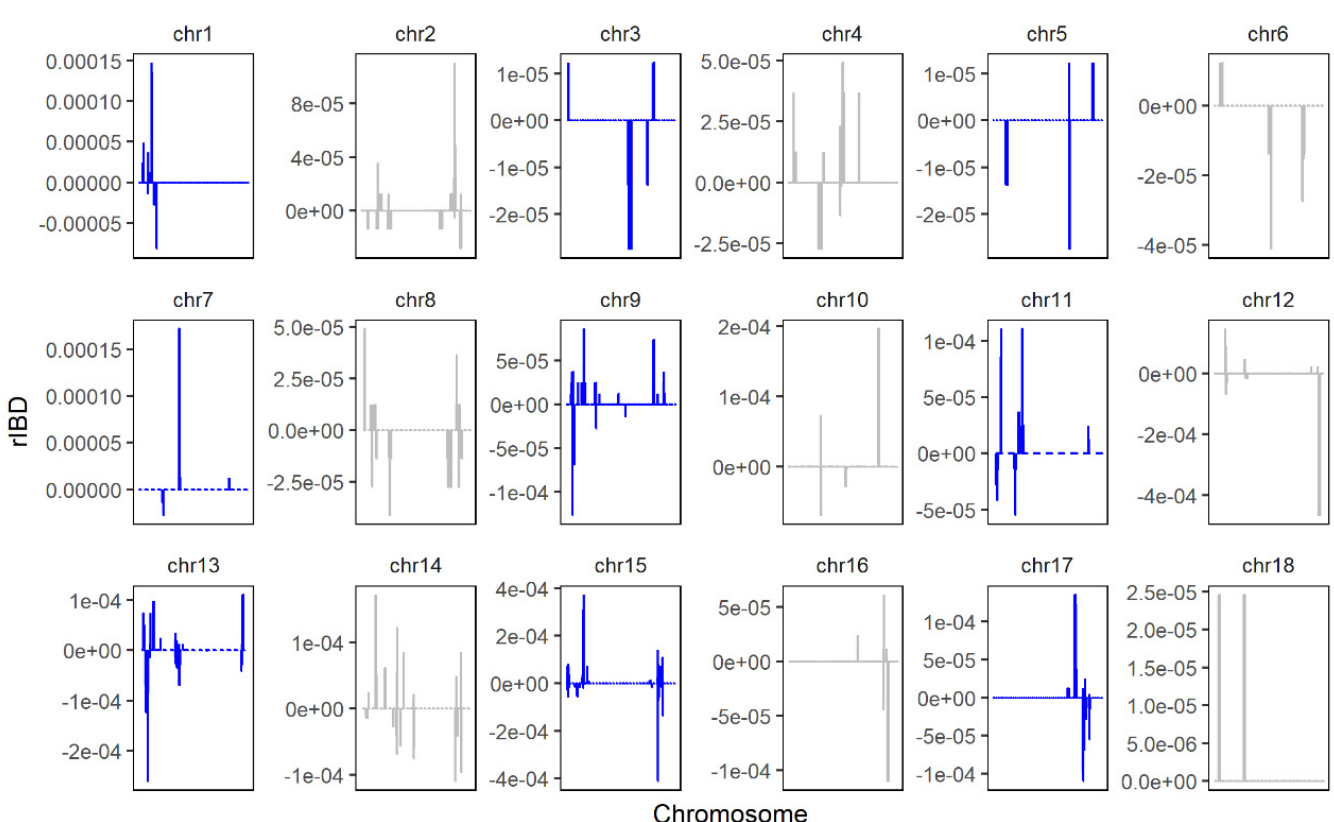
Figure 7. rIBD results of LU–LW and LU–YY pigs by SNP chip. Positive values represent rIBD between LU and LW pigs, which means the sequence was introgressed from LW to LU pigs. Negative values represent rIBD between LU and YY pigs, which means the sequence was introgressed from YY to LU pigs.